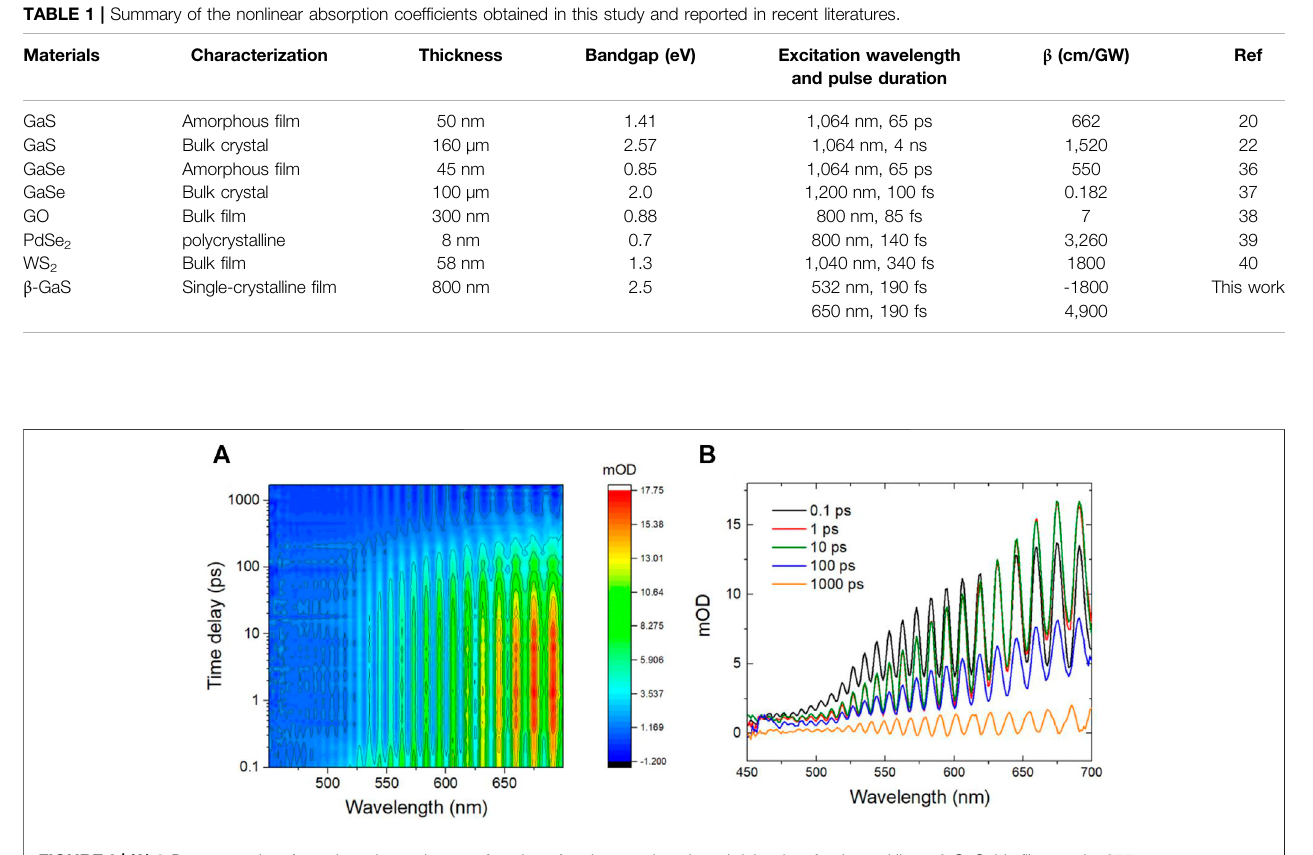
FIGURE 3 | (A) 2-D contour plot of transient absorption as a function of probe wavelength and delay time for the multilayer β -GaS thin fi lms under 355 nm pump. (B) 1-D slice from the contour plot of transient absorption of GaS fi lms at various delay